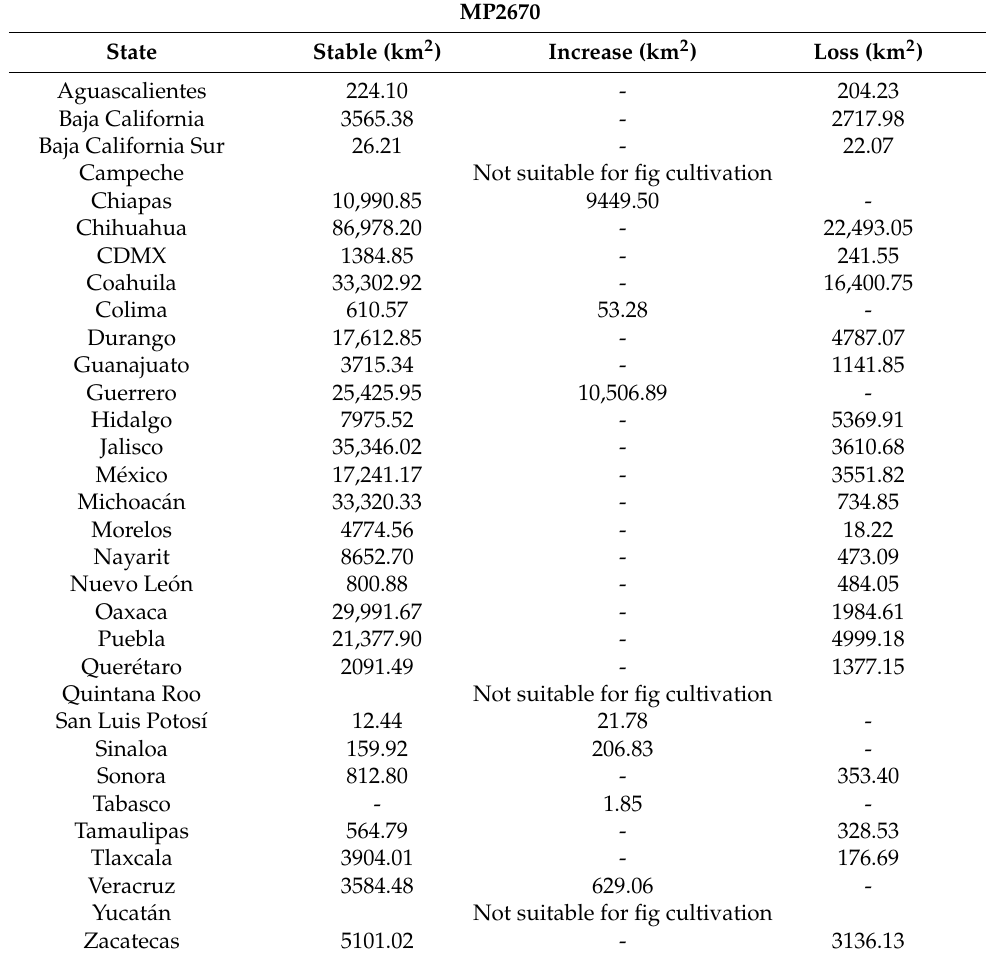
Table A7. Area estimated of fig crop for the year 2070 for the MPI-ESM-LR Model with RCP 2.6.